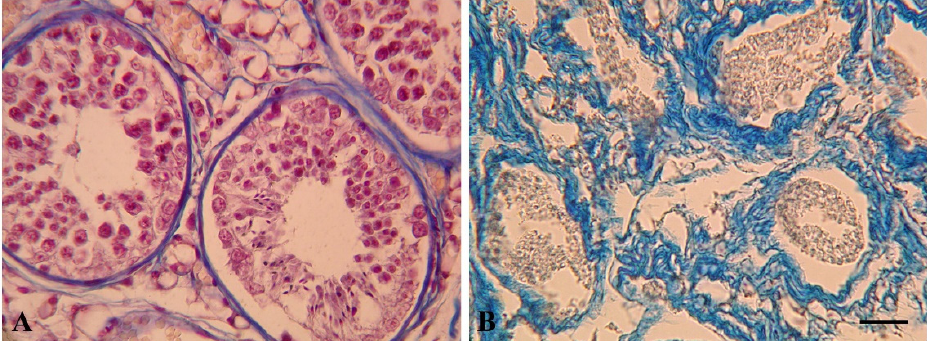
Figure 3. Histological sections of testis of P. macrocephalus . ( A ) ID 174: seminiferous tubules were large with an open lumen and a complex seminiferous epithelium where spermatogonia, spermatocytes and spermatids are recognizable. ( B ) ID 456: seminiferous tubules were in advanced autolytic state and surrounded by abundant interstitial tissue. Scale bar: 30 µ